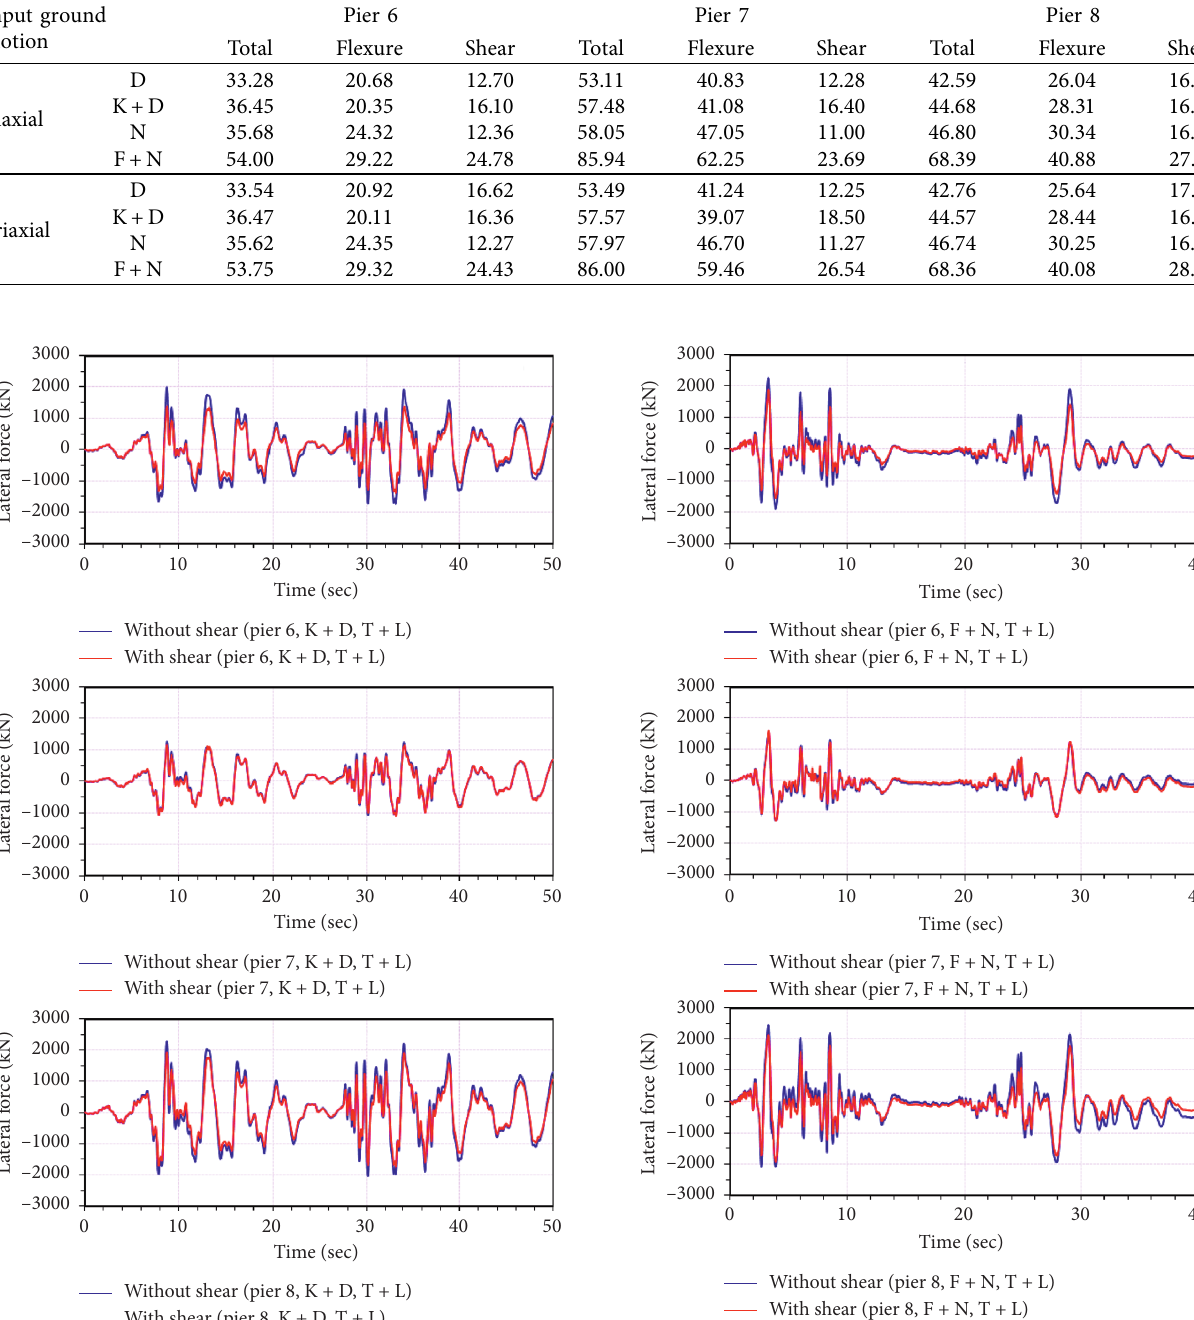
Table 4: Maximum transverse displacement component for the model with shear (in mm).